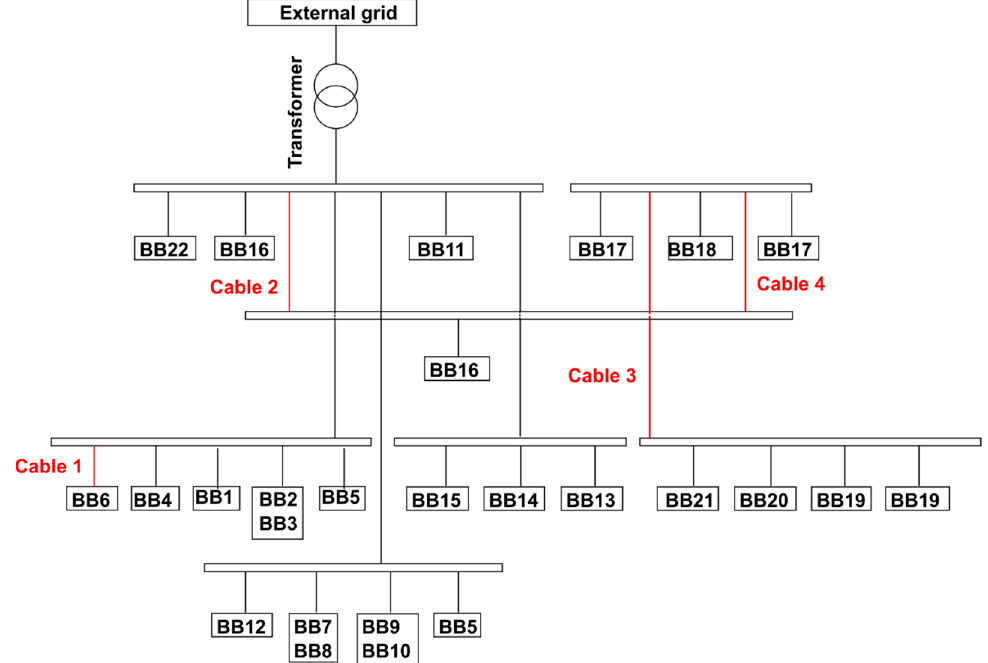
Figure 4. One-line diagram of the case study 400 V grid.